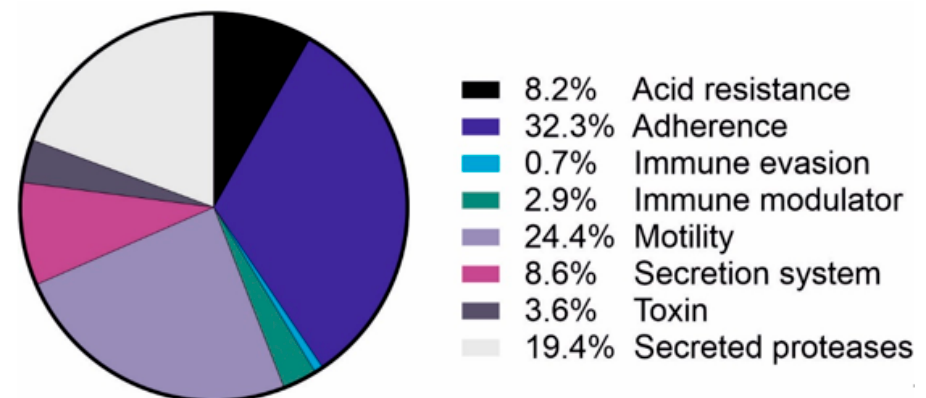
Figure 1. Virulence factors detected in H. pylori -derived OMVs. Identified virulence factors of H. pylori by mass spectroscopy [38–42,45] and their role in bacterial pathogenesis.